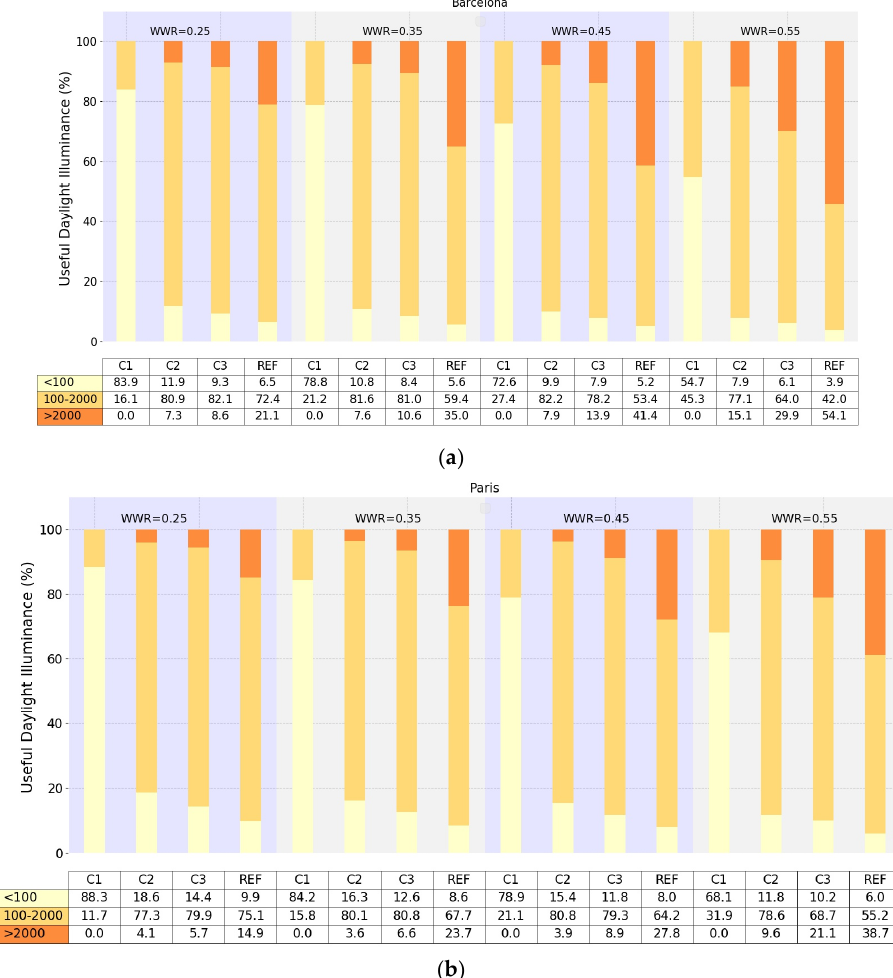
Figure 9. Useful daylight illuminance: ( a ) Barcelona; ( b ) Paris.